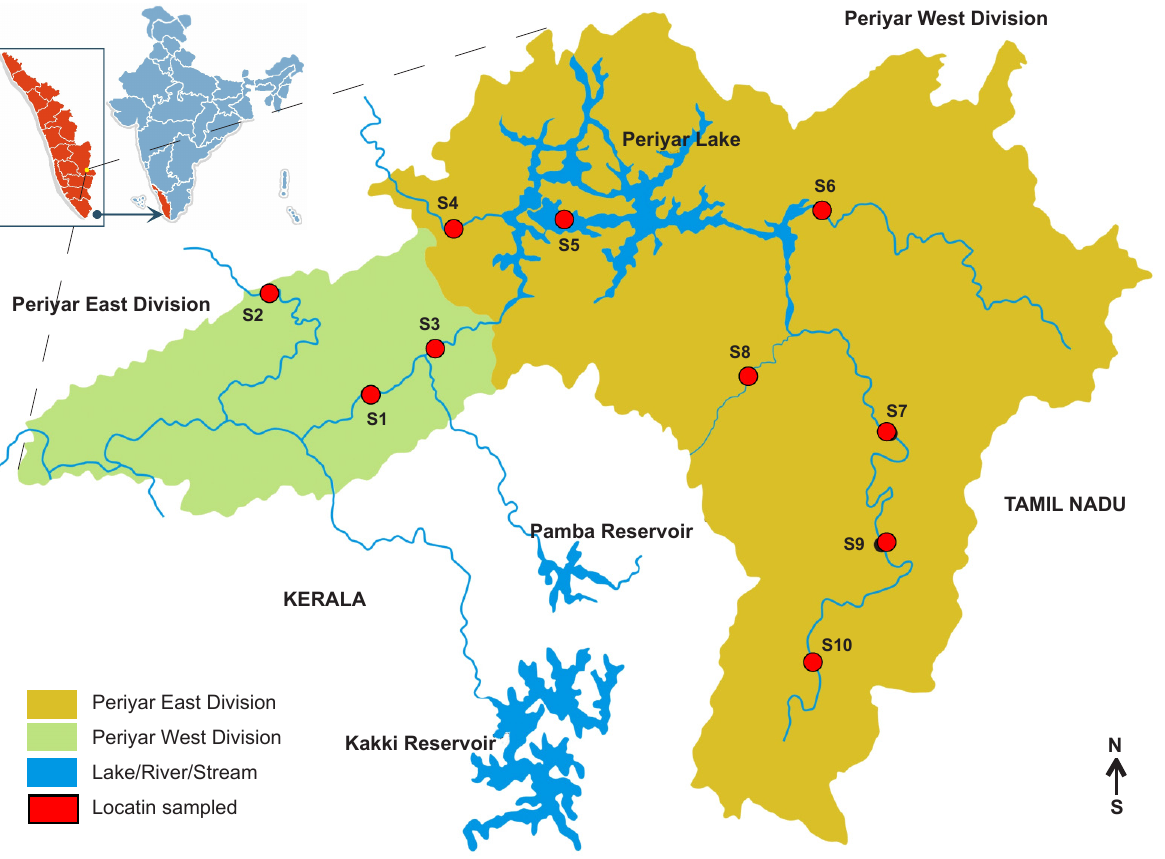
Figure 1. Map of Periyar Tiger Reserve showing the locations sampled for fishes during the period of study. S1 - Pamba; S2 - Azhutha; S3 - Pachakkanam; S4 - Vallakkadavu; S5 - Periyar Lake; S6 - Mullayar; S7 - Thannikkudy; S8 - Ummikuppanthodu; S9 - Mlappara; S10 -